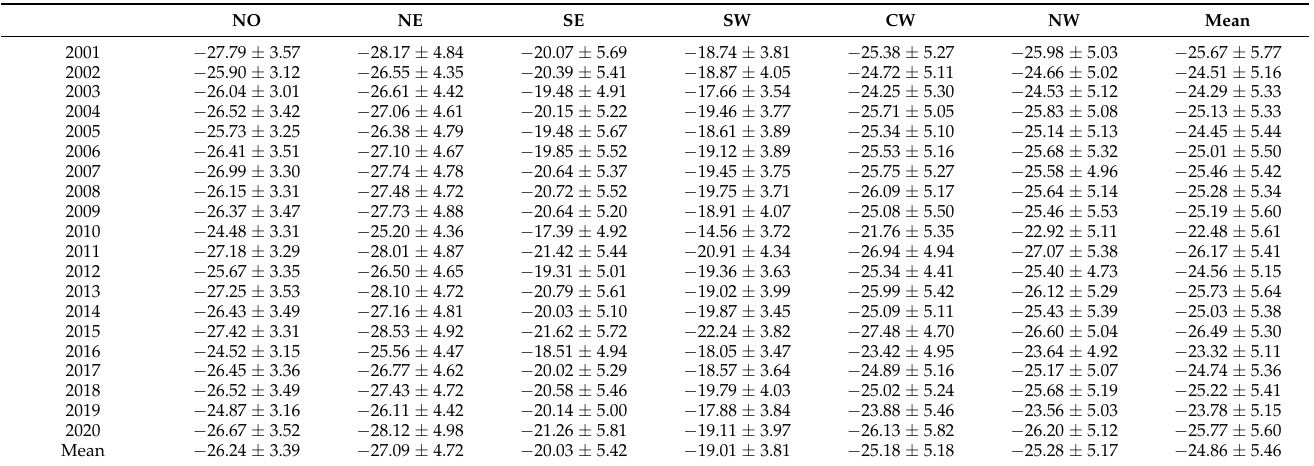
Table 1. Mean annual temperature and standard deviation of the GrIS, as a whole and for basins (°C).